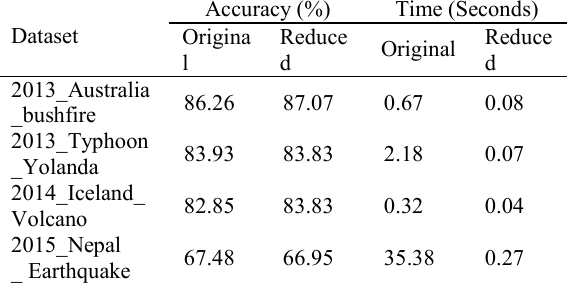
Table 9. Performance of the feature selection analysis on different datasets by Naïve Bayes